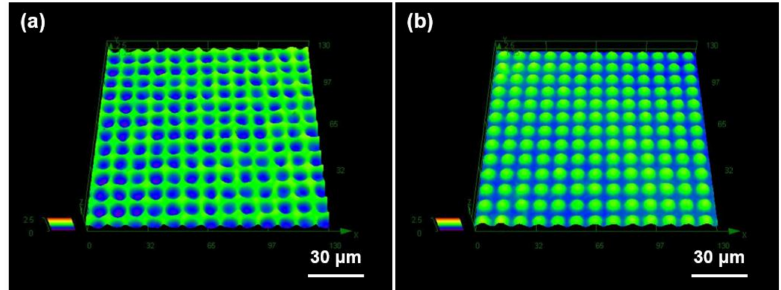
Figure 4. Three-dimensional surface profiles of ( a ) a GC mold and ( b ) a DMF microdome Al substrate obtained by laser confocal